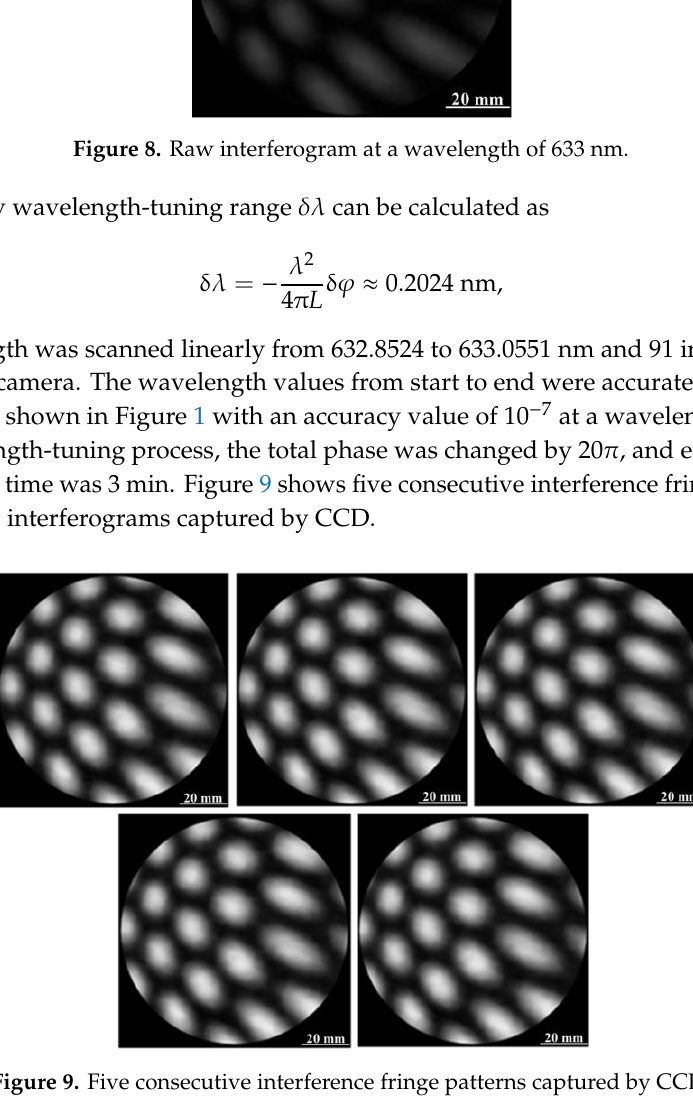
Figure 9. Five consecutive interference fringe patterns captured by CCD.